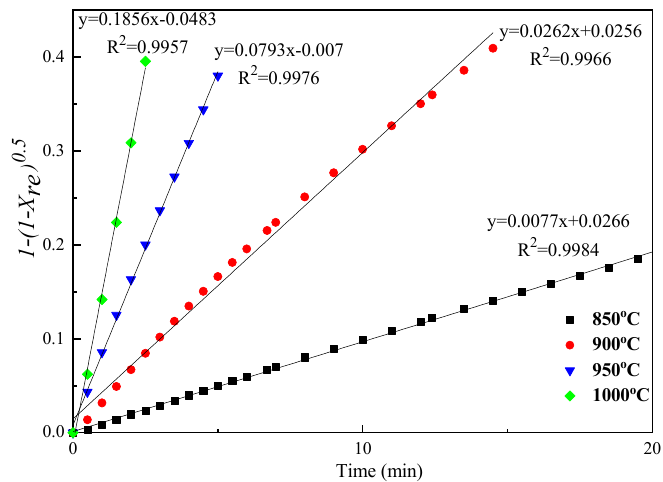
Figure 7. Kinetic regression results based on the geometrical contraction model (R2) for the reduction of CZ230-S1 conducted with various operating temperatures.